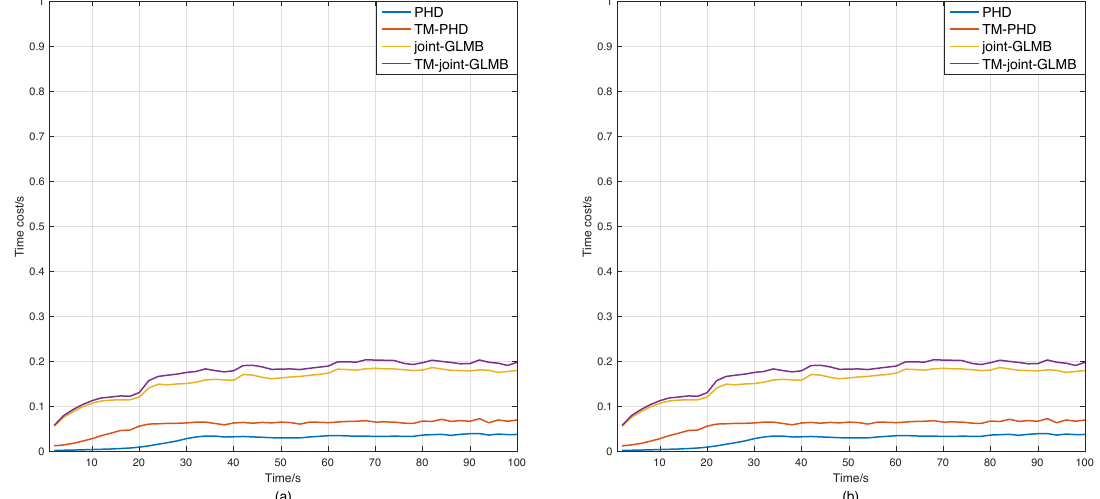
Figure 8. Time costs of the original RFS-based filters and the time-matching filters. ( a ) Scenario 3. ( b ) Scenario